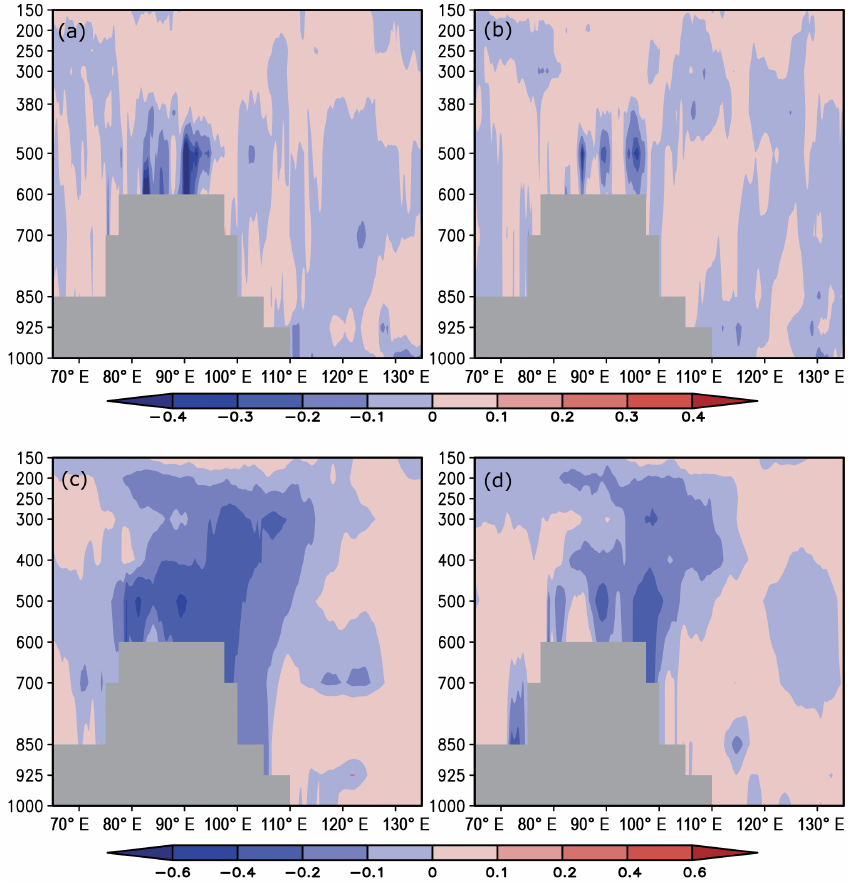
Figure 9. Longitudinal cross section of the differences between CON and SEN averaged over 32–36 ◦ N in summer. (a, b) Net radiative cooling rate (shortwave heating rate plus the longwave cooling rate, ◦ Cday − 1 ) in heavy and light dust years, respectively. Panels (c) and (d) are similar to (a) and (b) but for atmospheric temperature ( ◦ C).